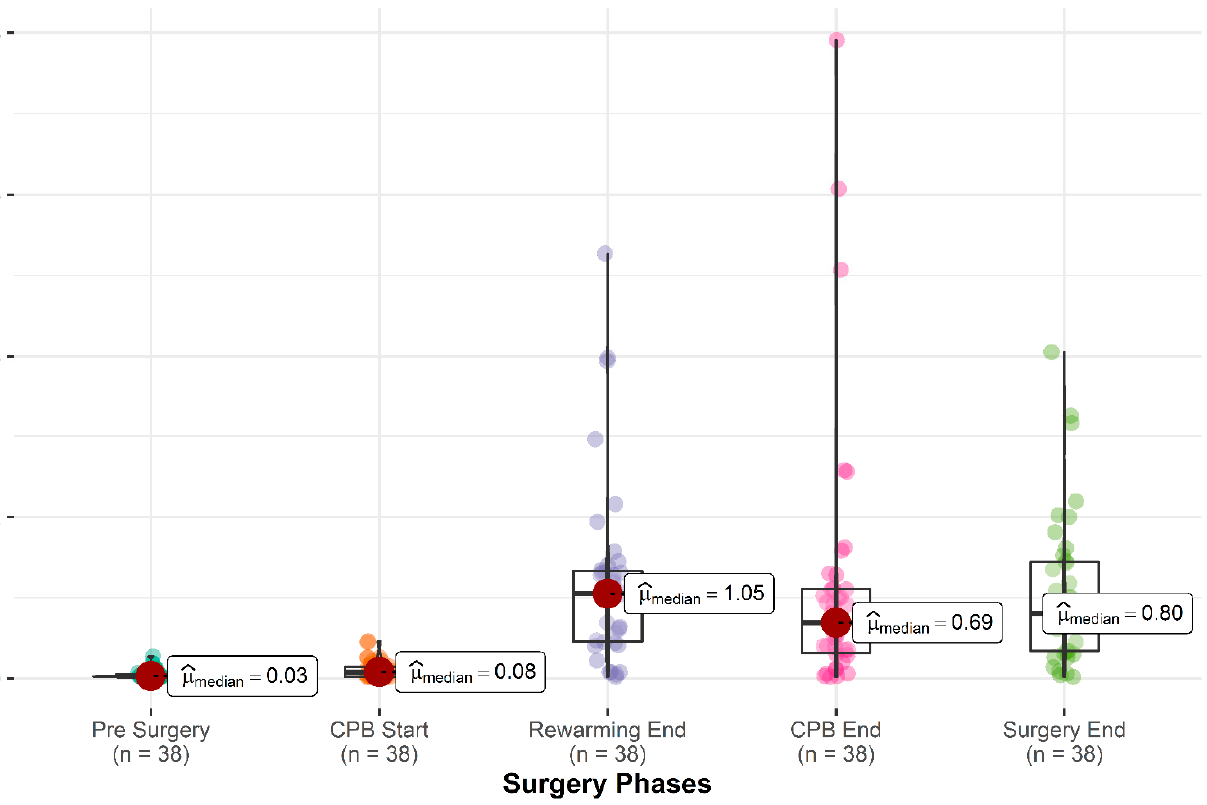
Figure 1. GFAP plasma level at prespecified intraoperative time points. Boxviolin plots for GFAP plasma level. Boxes represent the interquartile range. CPB, cardiopulmonary bypass; GFAP, glial fibrillary acidic protein.